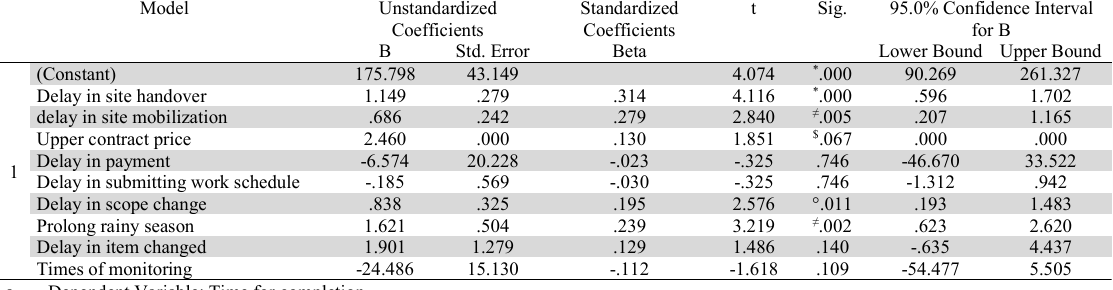
Coefficients in case of dependent variable time for completion Model Unstandardized Standardized